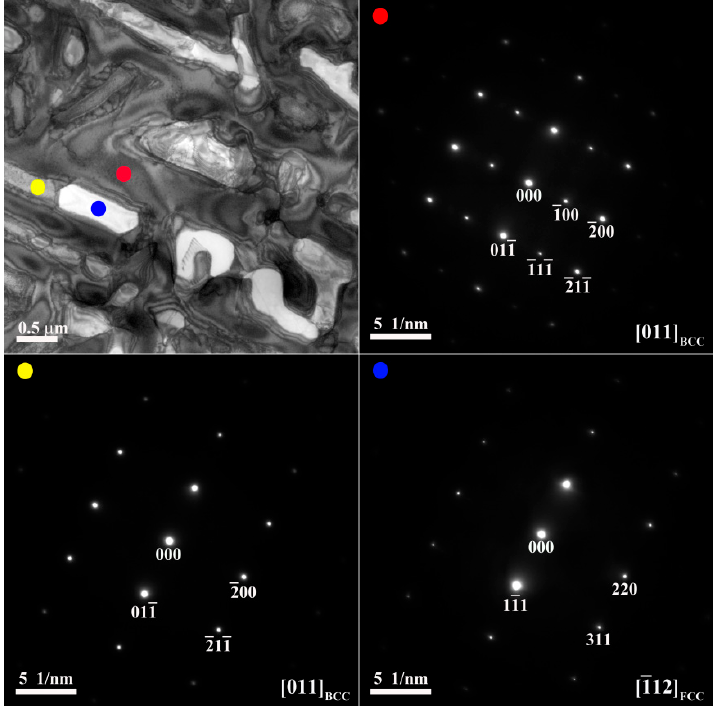
Figure 3. TEM bright-field images and SAED patterns of the dendrite for the X 0 as-cast alloy (red dot: ordered BCC; yellow dot: BCC; blue dot: FCC).